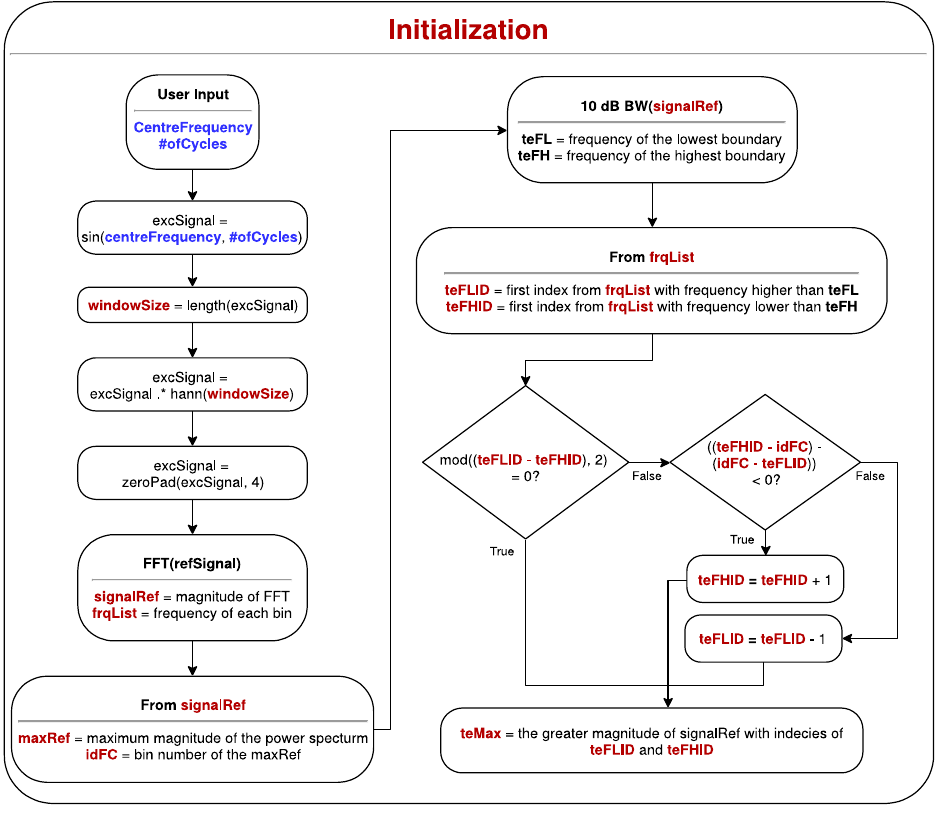
Table 1. Description of variables extracted from the Initialisation.